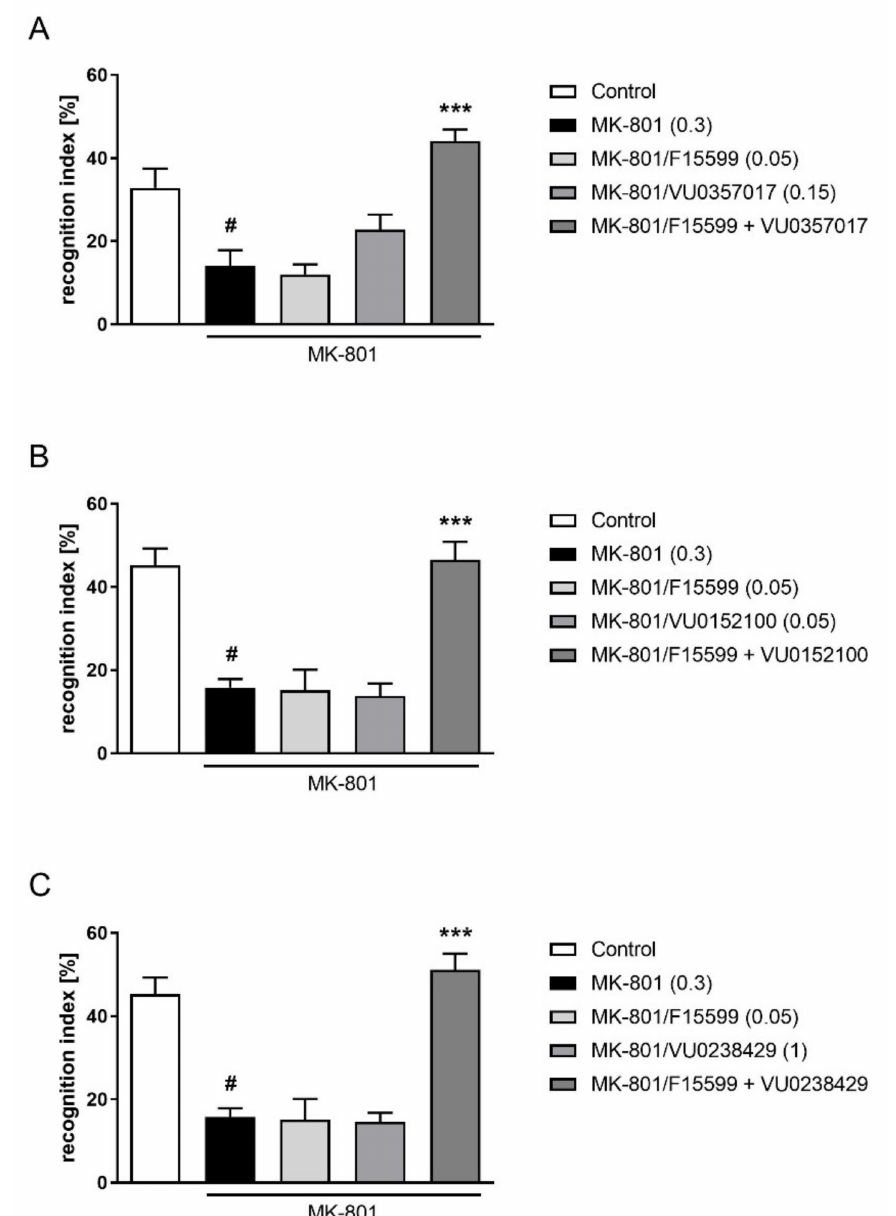
Figure 11. Activity of the combined administration of subeffective dose of F15599 with subeffective dose of VU0357017 ( A ), VU0152100 ( B ), or VU0238429 ( C ) in the NOR test after seven days of treatment. The data are presented as means ± SEM. Doses of the compounds are indicated in parentheses. # p < 0.01 ( A ) or # p < 0.001 ( B , C ) compared to control animals and *** p < 0.001 compared to MK-801-treated mice. The combined administration of a subeffective dose of F15599 (0.025 mg/kg) with (1 mg/kg) did not reverse MK-801-induced disruptions in Y-maze (Figure